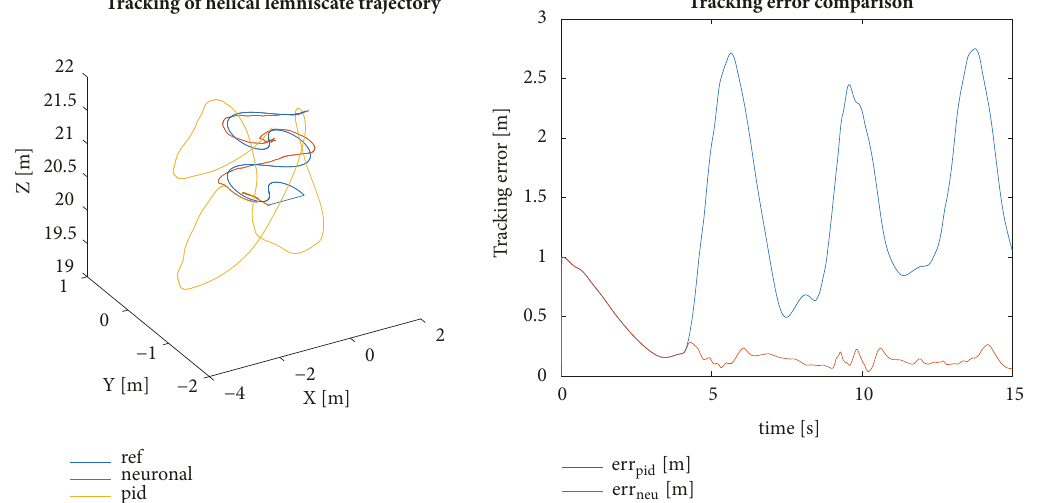
Figure 20: UAV tracking of a helical lemniscate trajectory with sinusoidal wind profile disturbance (left) and its tracking error (right).